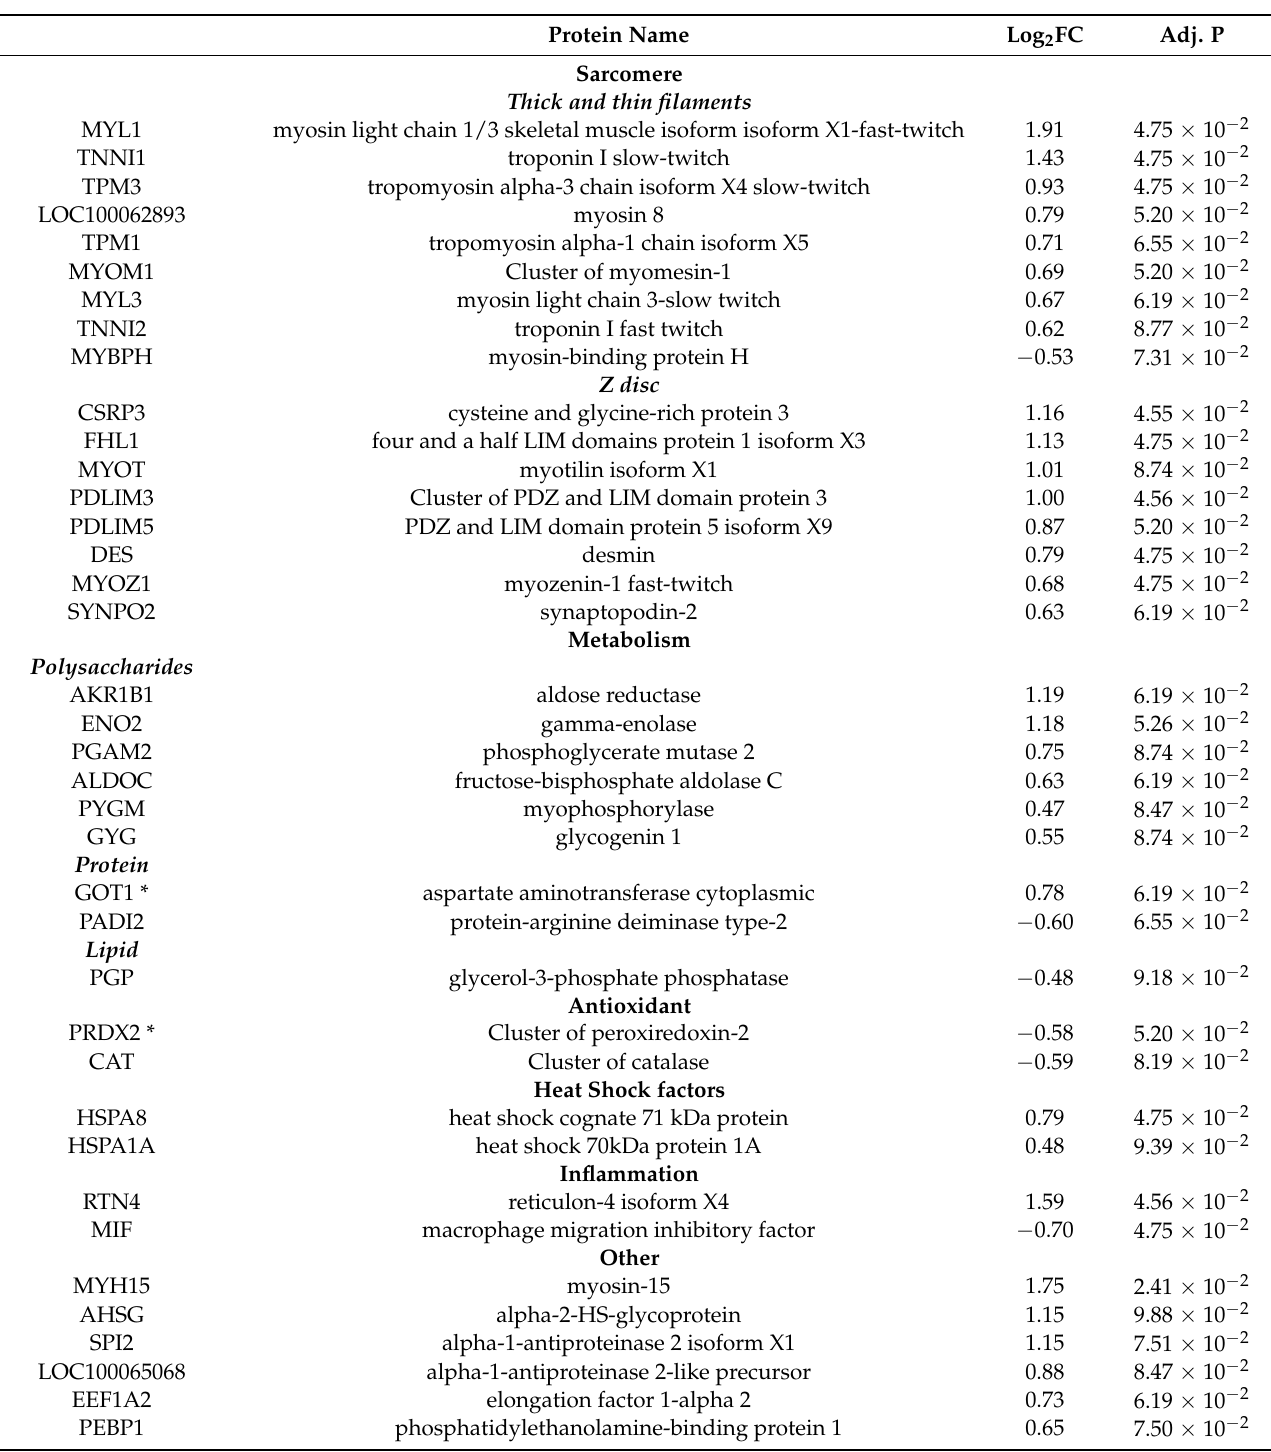
Table 4. Differentially expressed muscle proteins (DEP) located in the myoplasm of Standardbred horses susceptible to recurrent exertional rhabdomyolysis compared to control. Proteins are identified by their gene ID and protein name, log 2 fold change (FC) and the p value adjusted for multiple comparisons are provided (FDR < 0.10). * indicates DEP that were also differentially expressed